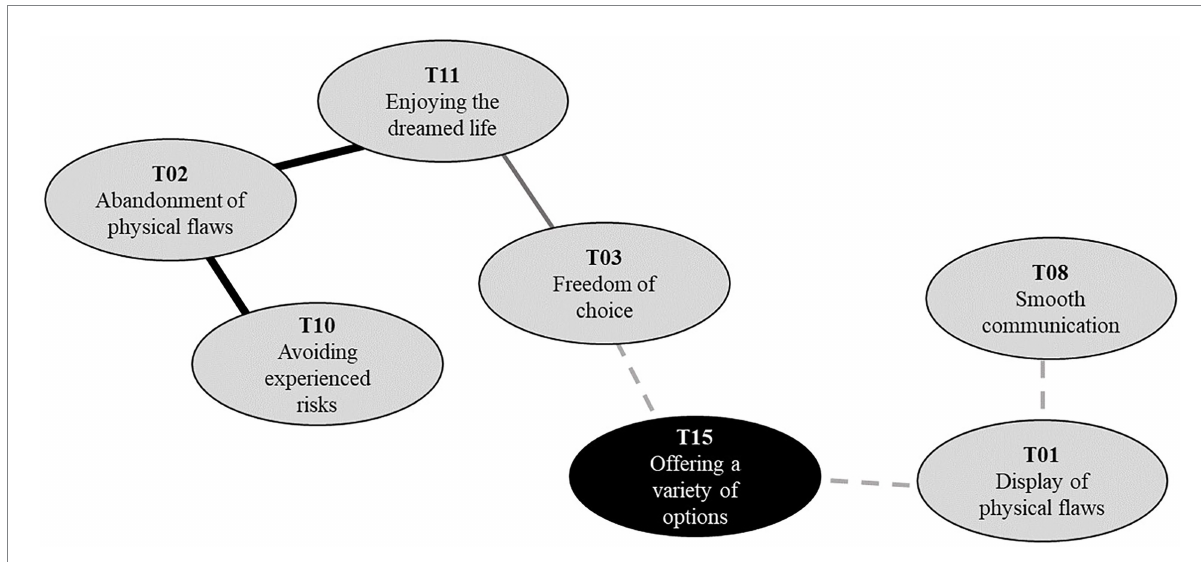
FIGURE 5 Bridge topic (colored black) connecting incompatible perspectives on avatar-based disability representations.